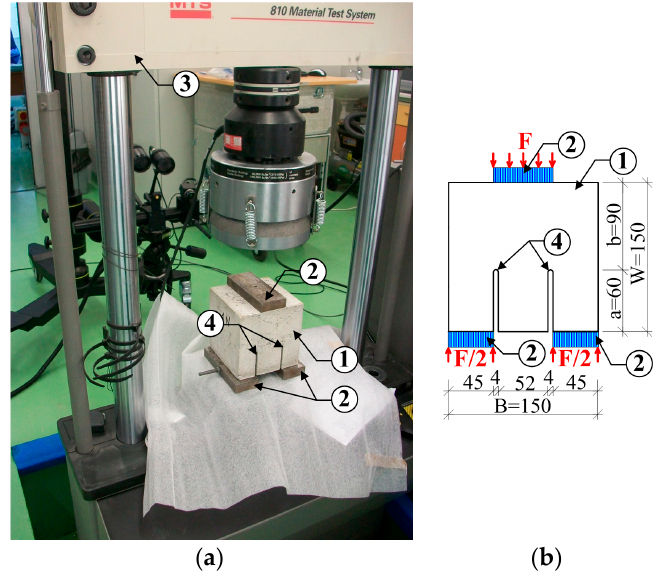
Figure 7. View of experimental stand for testing according to mode II fracture: ( a ) specimen during testing, ( b ) specimen with dimensions and loading conditions; 1—specimen, 2—stiff plate, 3—MTS 810 press, 4—initial crack (dimensions in mm).